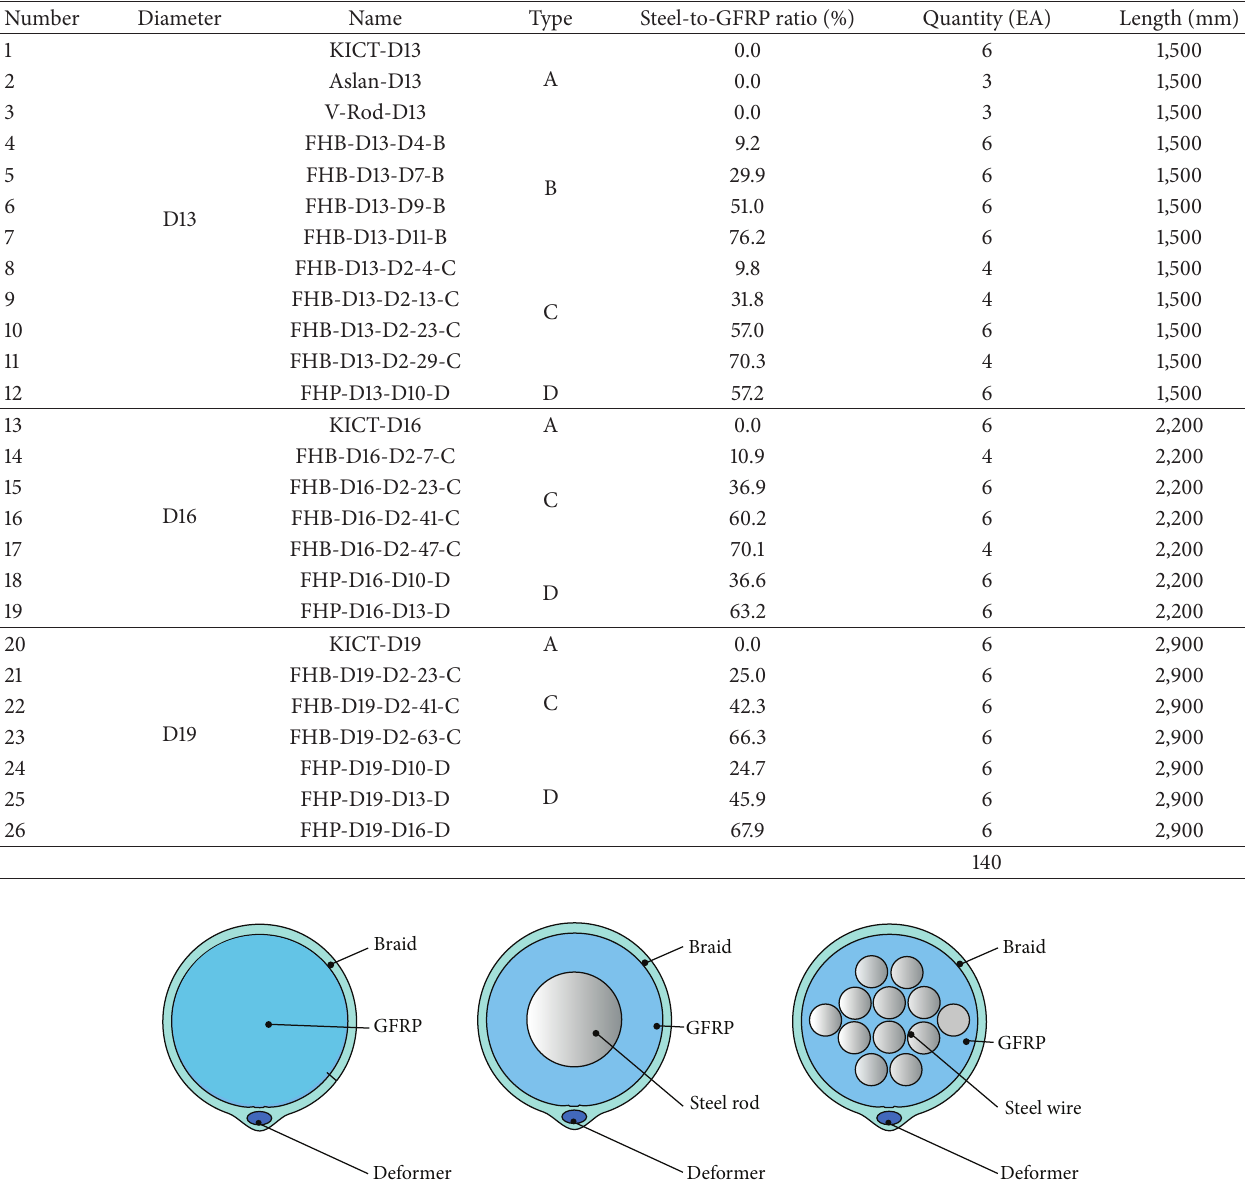
Table 1: List of specimens for tensile test.